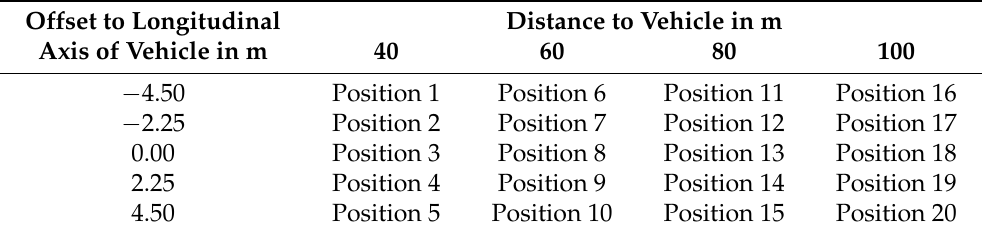
Table 1. Assignment of object positions to measuring grid points in the light